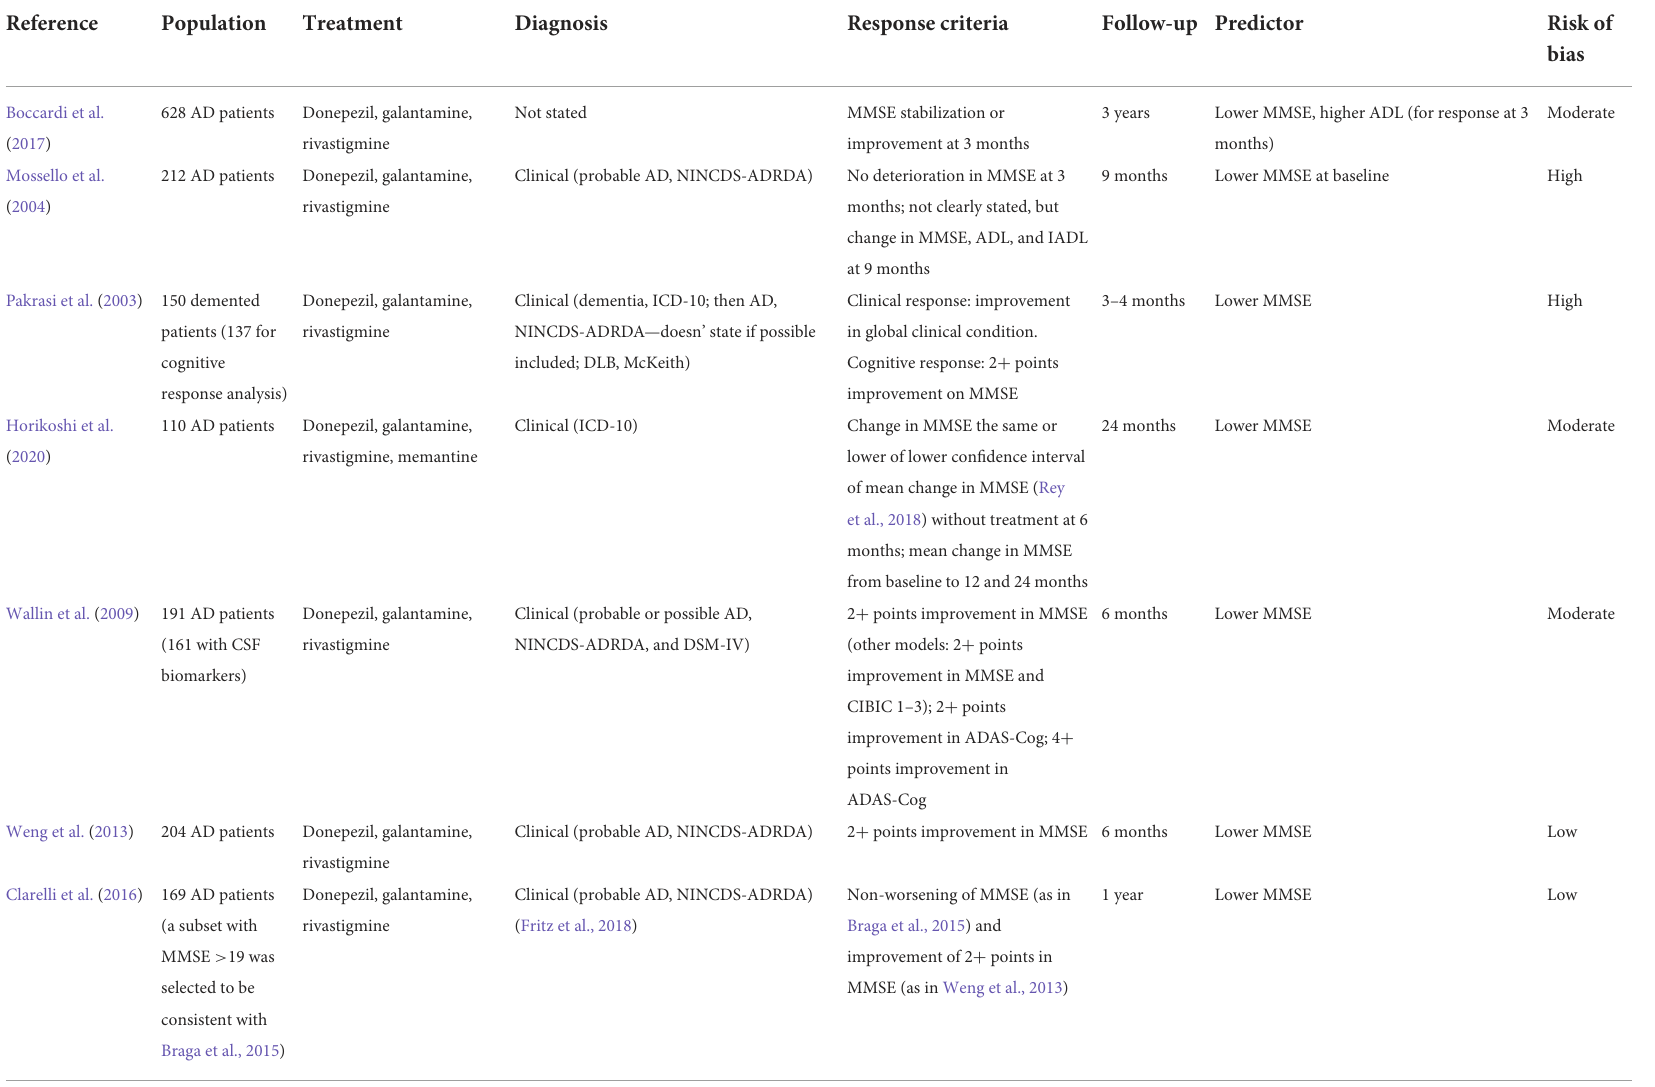
TABLE 8 Measures of cognitive or functional impairment at